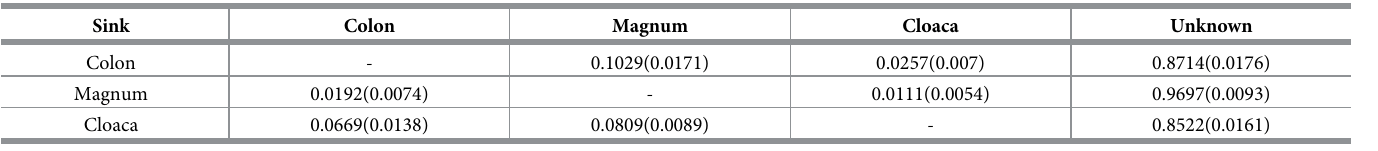
Table 6. Contribution of each source to each